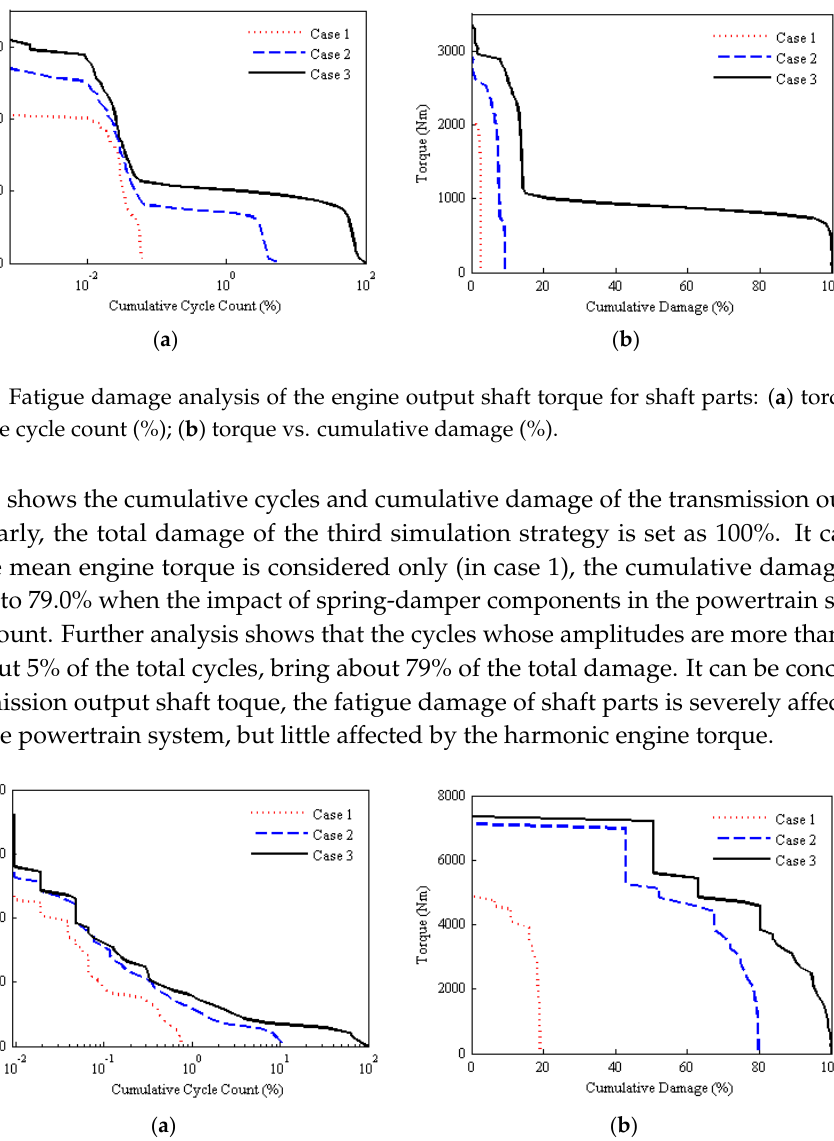
Figure 12. Fatigue damage analysis of the transmission output shaft torque for shaft parts: ( a ) torque vs. cumulative cycle count (%); ( b ) torque vs. cumulative damage (%).